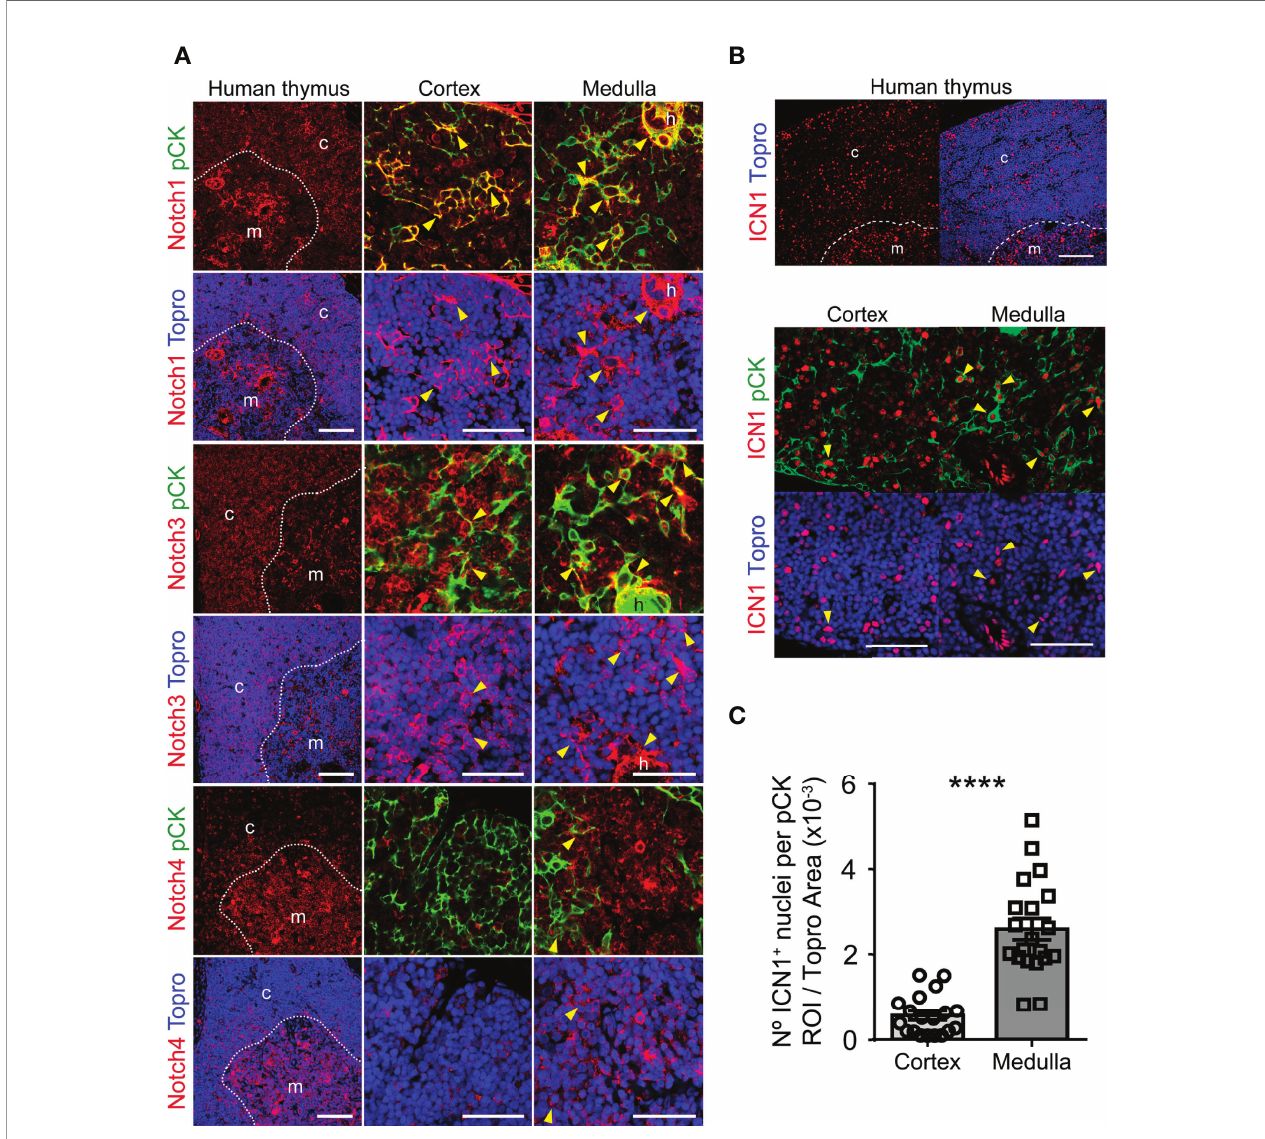
FIGURE 2 | Expression of Notch receptors and activation of Notch1 signaling in human postnatal thymus. (A) Immunohistochemistry of the indicated Notch receptors in the human postnatal thymus ( ≤ 18 months). TECs are characterized by pCK expression (green). Topro3 shows nuclear staining (blue). General view (scale bar: 100 m m) of Notch receptor distribution in representative human postnatal thymus samples, and detailed view (scale bar: 50 m m) of Notch receptor expression by TECs located at the cortex and medulla. Dotted line, corticomedullary junction; c, cortex; m, medulla. Arrowheads indicate Notch receptor expression by TECs (pCK + ). Images shown are representative of n ≥ 5 different 63x images from n = 2 independent human thymus samples. (B) Immunohistochemistry of active intracellular Notch1 (ICN1) (red) in representative human postnatal thymus samples ( ≤ 6-years). TECs are characterized by expression of pCK (green). Topro3 shows nuclear staining (blue). General view (scale bars: 100 m m) of ICN1 expression (top) and detailed view (scale bars: 50 m m) of ICN1 and pCK staining in human thymus cortex and medulla (bottom). Dotted line, corticomedullary junction; c, cortex; m, medulla. Arrowheads indicate ICN1 expression in TECs. (C) Bar graphs showing numbers of ICN1 + nuclei within pCK + ROIs relative to total (Topro + ) cellular areas analyzed in human thymus cortex and medulla samples. Data are shown as mean numbers ± SEM per fi eld obtained from n=10 different 63x images per thymus sample (n=3 independent thymus samples aged ≤ 6-years), ****p <